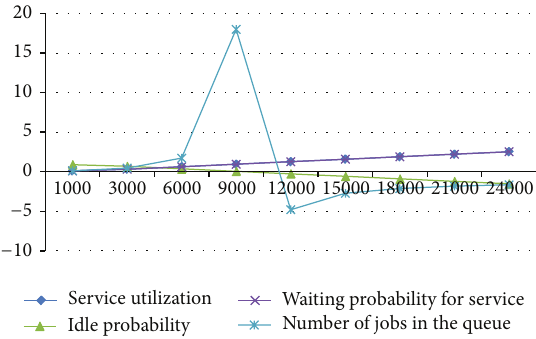
Figure 7: Experimental results by increasing service rates